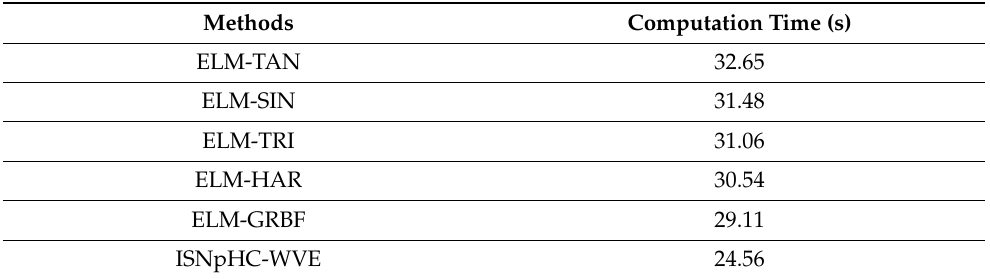
Figure 7. Comparative results analysis of ISNpHC-WVE technique on soil pH classification. Table 4. Computational time analysis of the ISNpHC-WVE with existing